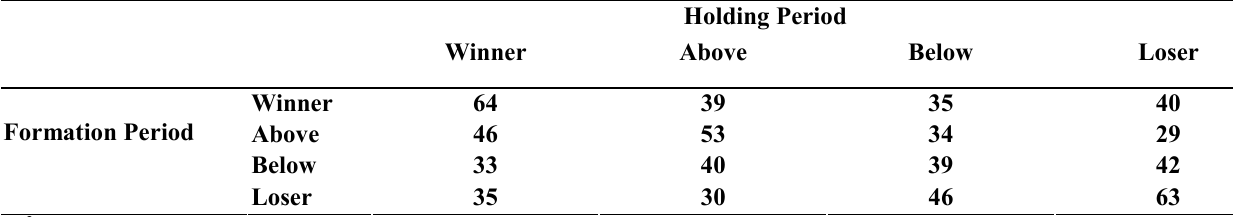
Table 2: Equity quartile summary table for 1 January 1989 to 31 December 1999: quarter predicting quarter